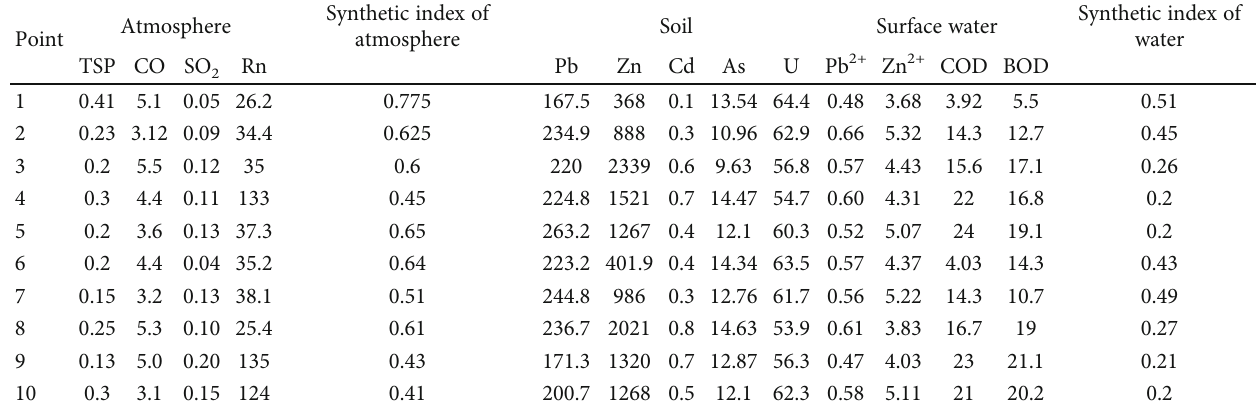
Table 3: Statistics of in fl uencing factors of atmosphere, soil, and water in coal mines.